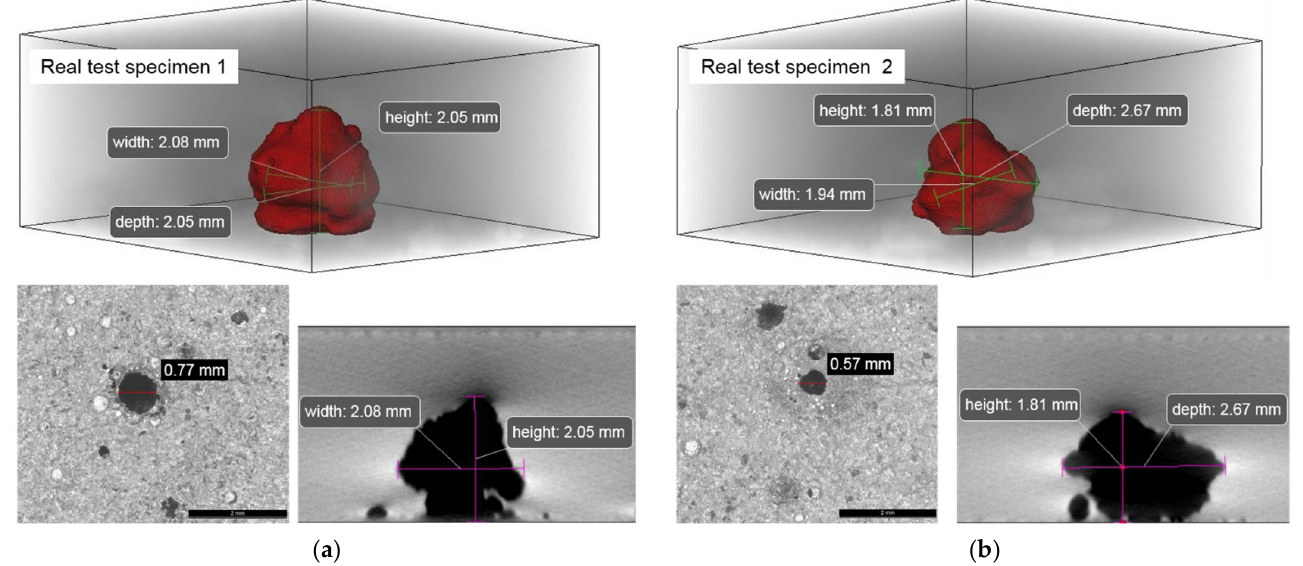
Figure 3. Real test specimen 1 ( a ) and 2 ( b ): volume reconstruction of pitting corrosion after computed tomography (CT) scan ( top ), specimen surface with size of pit opening ( bottom left ) and cross-section through greatest height of corrosion in CT measurement data ( bottom right ).